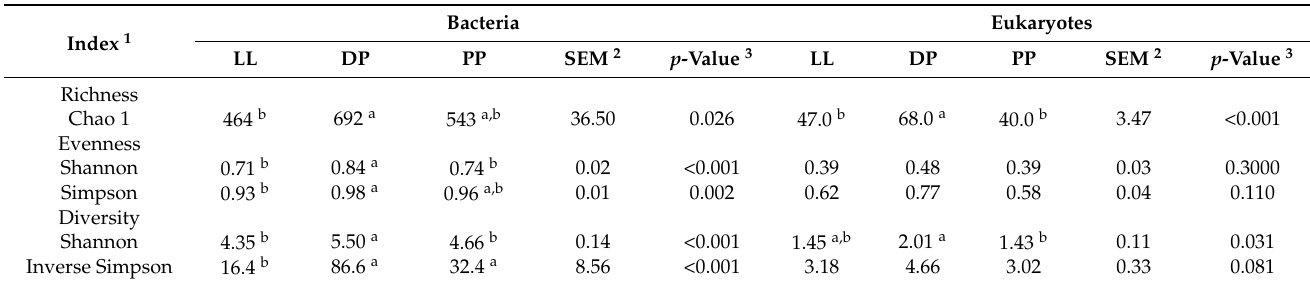
Table 2. Comparison of various alpha-diversity estimators of active rumen bacterial and eukaryotic communities of different physiological